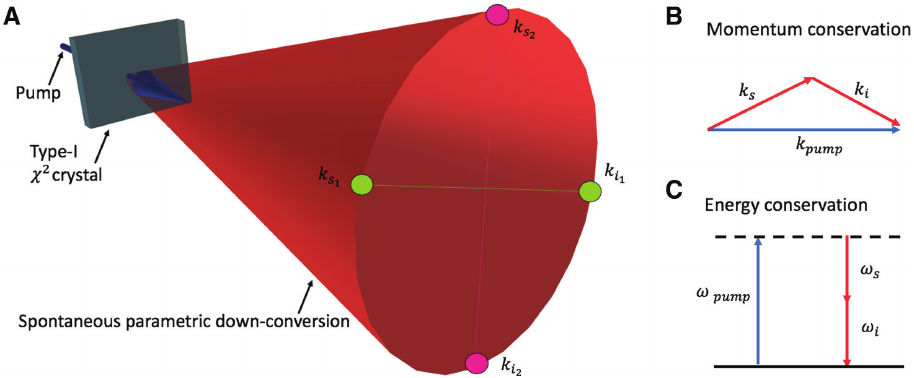
Figure 4: Spontaneous parametric down-conversion (SPDC) process and the conservation of momentum and energy. (A) The process of SPDC is produced by pumping a χ (2) nonlinear crystal. SPDC photons are generated at the same spatial position in the crystal; consequently, photon pairs are correlated in the variable of spatial position. The conservation of linear momentum shown in (B) forces a pair of SPDC photons to be anticorrelated in the variable of linear momentum; consequently, photons located in opposite positions of the down-conversion cone show nonclassical correlations. (C) The process of SPDC satisfies the conservation of energy; in this case, a blue photon is annihilated to create two red photons. Reproduced from Ref.